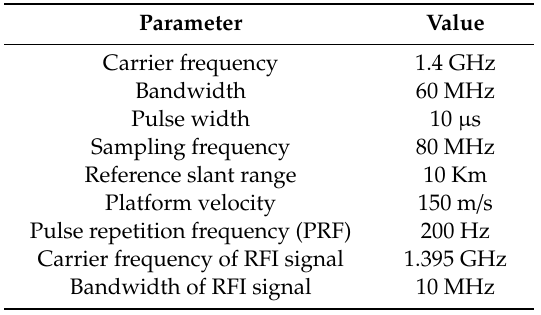
Table 7. Simulation parameters of the SAR data.